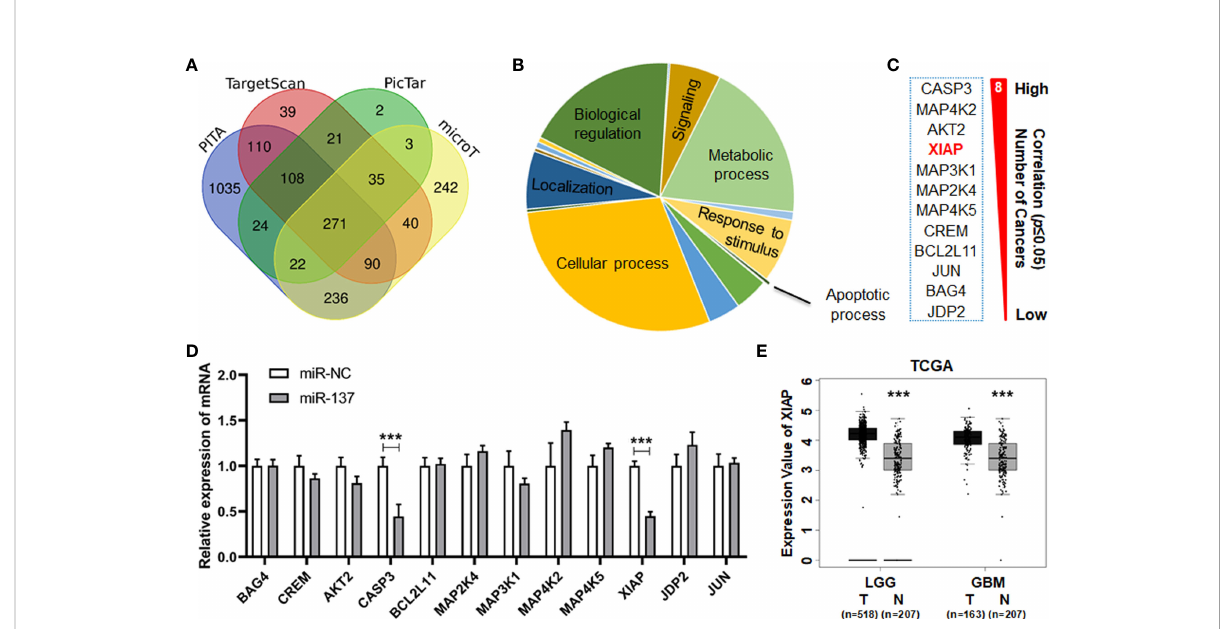
FIGURE 3 miR-137 may be the regulator of XIAP. (A) Predicted target genes of miR-137 collected from four prediction algorithms (PITA, TargetScan, PicTar and microT). (B) All the predicted target genes classi fi ed by biological process according to the PANTHER classi fi cation system (http://pantherdb.org/ ). Identify critical genes related to apoptotic process. (C) Gene list correlated with the apoptosis signaling pathway. The reverse relationship between miR-137 and these candidate target genes were analyzed in TCGA database (ENCORI website).